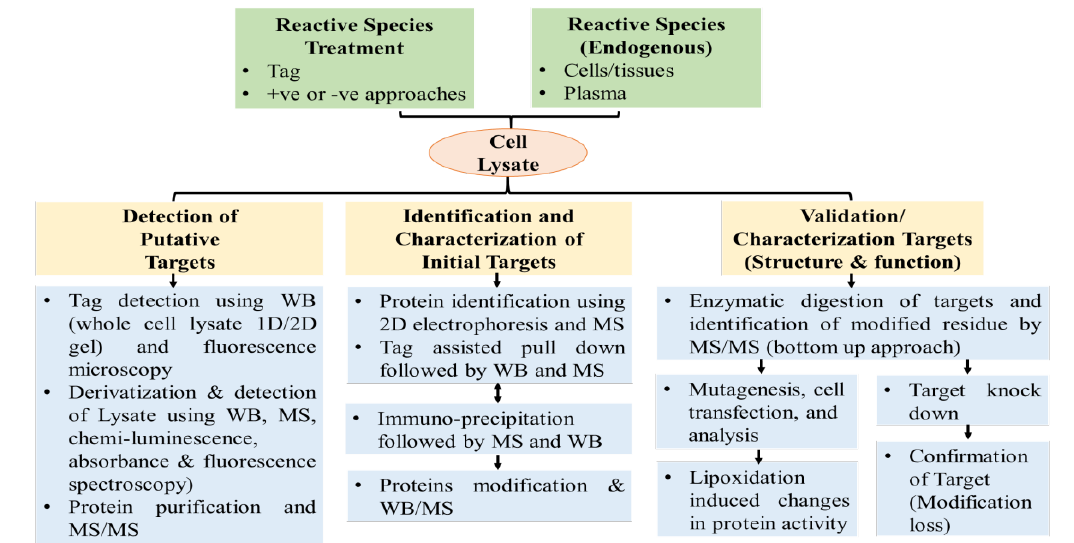
Figure 5. Methods for validation of lipoxidation targets.